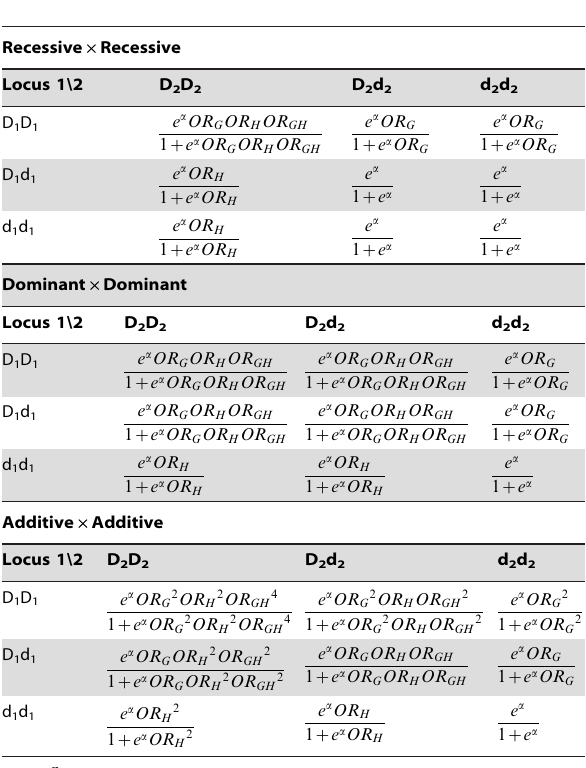
The elements in the Table are the penetrance as a function of the joint genotype at loci 1 and 2 with rows indexing genotype at locus 1 and columns indexing genotype at locus 2.